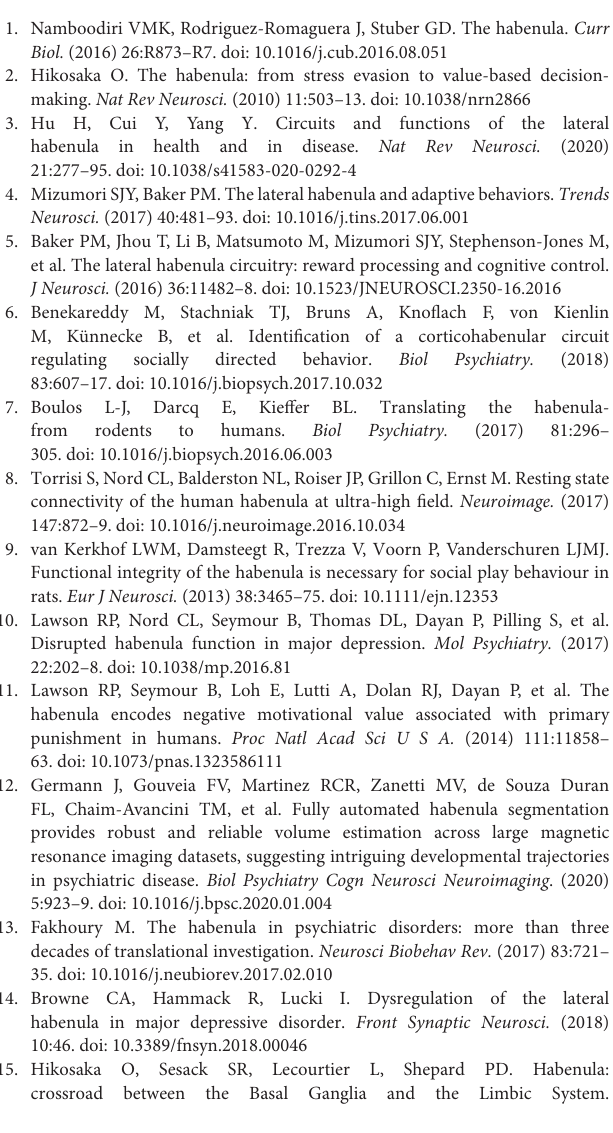
Supplementary Figure 1 | Study flowchart. Three separate analyses were performed: a retrospective baseline volume analysis, a retrospective longitudinal volume analysis, and a prospective fMRI functional connectivity analysis. DBS , deep brain stimulation; FC , functional connectivity; SCC , subcallosal cingulate area.